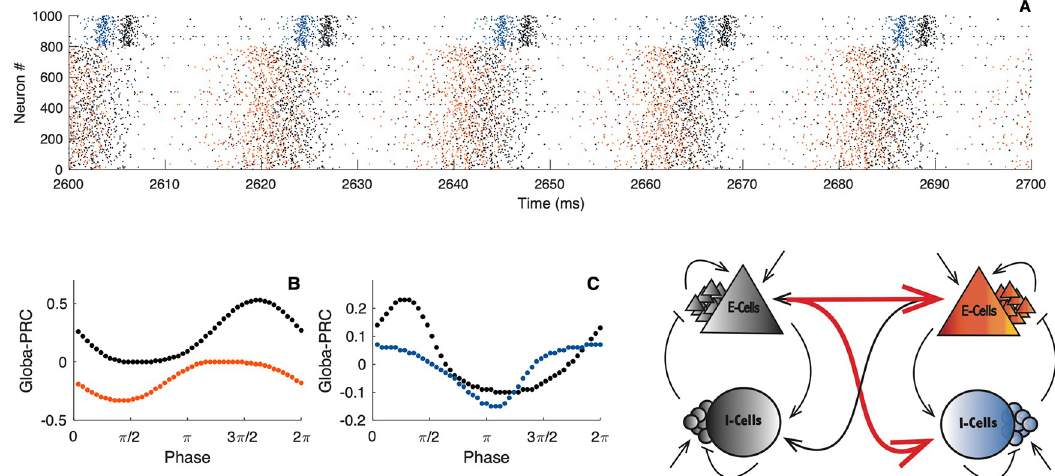
Fig 10. Summary of the resulting directionality. A) Raster plot of the spiking activity of the two networks, black dots indicate the spiking activity of the leader, dots in color, the activity of the follower. B-C) Global PRC obtained from direct perturbation of the leader in black and in the follower in color. In panel B, the perturbation is made on the E-cells, in panel C, the perturbation is made on the I-cells. Lower right panel illustrates the emerging directionality of the signal flow. Parameters: N = τ si = 1; � Z ¼ � Z ¼ (cid:0) 5 ; J ee = 0; J ei = 15; J ii = 0; J ie = 15; I ext e i perturbations are made with a square wave current pulse (amplitude 1, duration